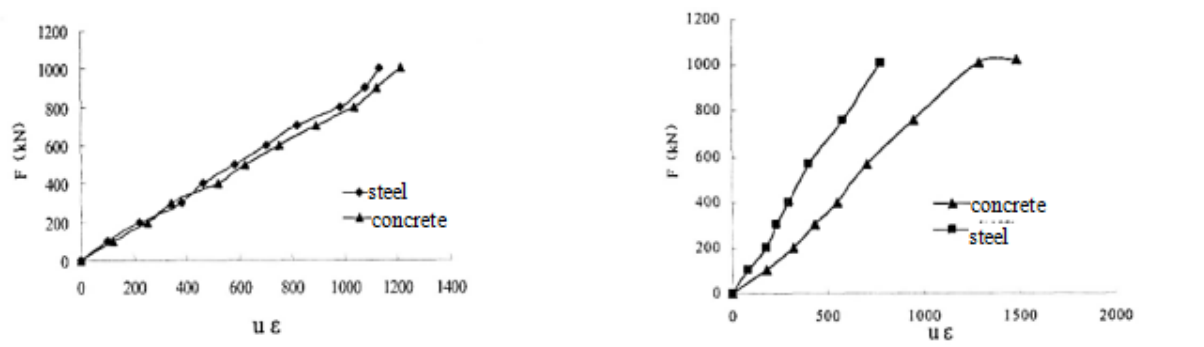
Figure 1: Load-strain curve of the non-tube pile. Figure 2: Load-strain curve of the buried tubes in the